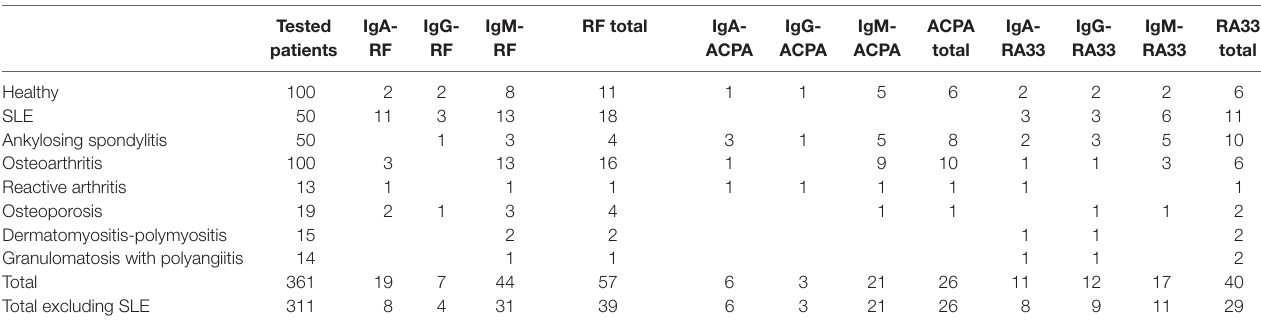
TaBle 3 | Antibody profile of healthy subjects and disease controls.